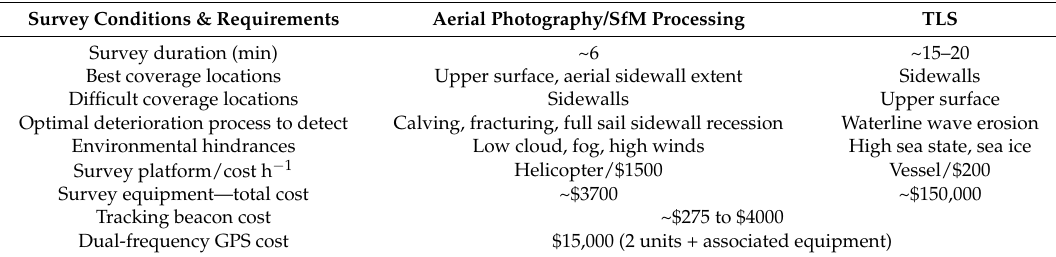
Field campaign considerations for aerial photography surveying (with subsequent structure-from-motion (SfM) processing) and terrestrial laser scanning (TLS) surveying. This list includes some of the factors that surveyors may contemplate when deciding between the use of these two survey techniques for future research programs. Costs are approximate. Further discussion on the benefits and limitations of these techniques for glaciological studies can be found in